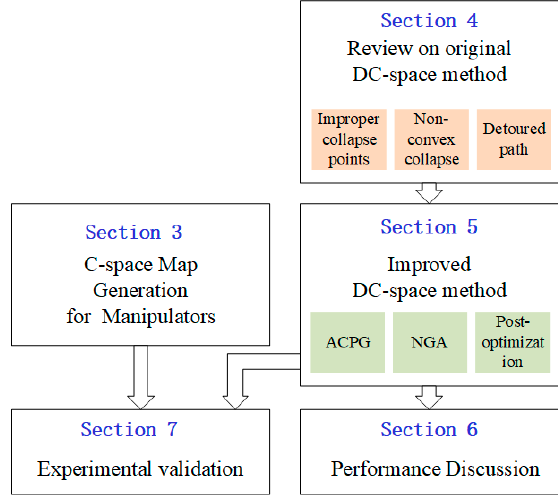
Figure 1. Framework of the